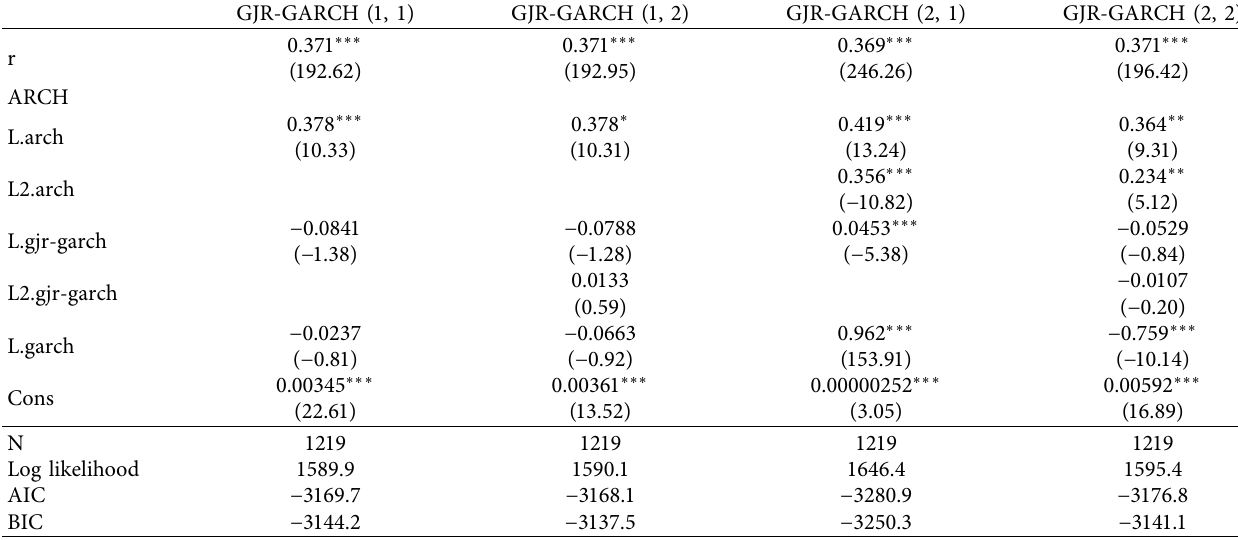
Table 6: Comparison of GJR-GARCH ( p , q )